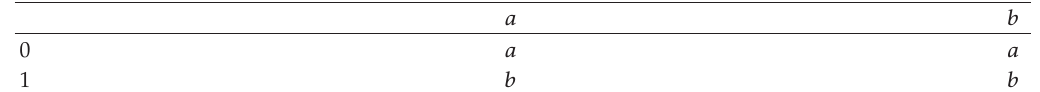
Table 2: Values of φ